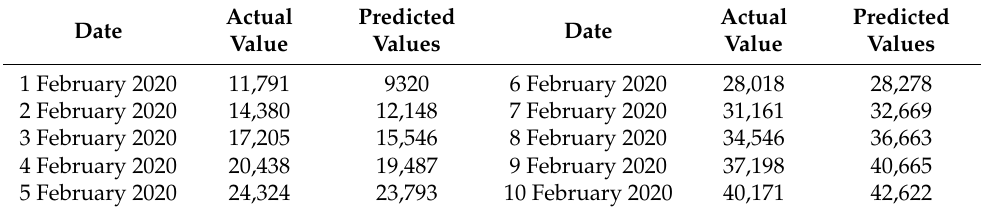
Figure 5. Forecast of COVID-19 pandemic in China. Table 3. Model prediction results of 𝐼(𝑡) .